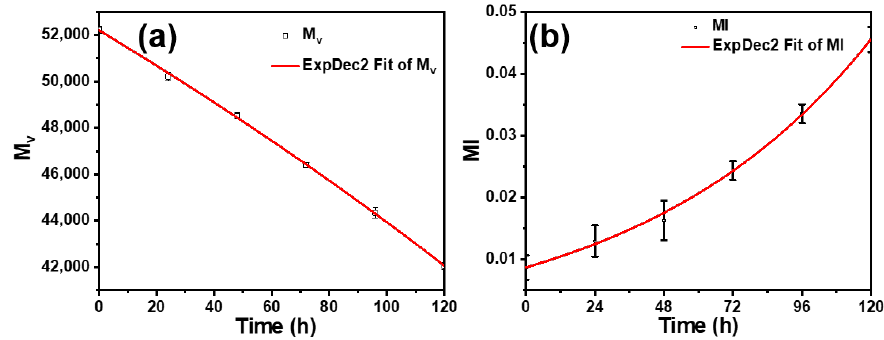
Figure 8. ( a ) Molecular weight change curves and ( b ) methyl index (MI) change curve of PE film. Scatter: experimental data. Red line: fitting by ExpDec2 model.